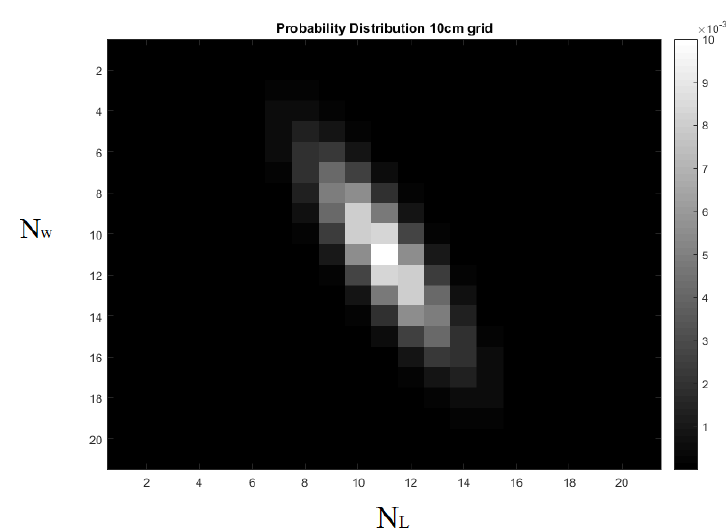
Figure 9. Computed result of the probability density function integrated on the